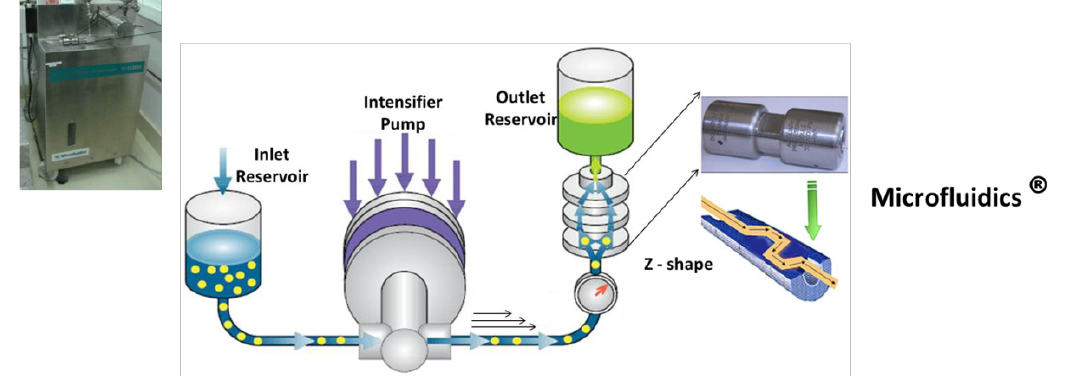
Figure 3. Description of one of most used devices to produce NFC—the microfluidizer from Microfludics ® .